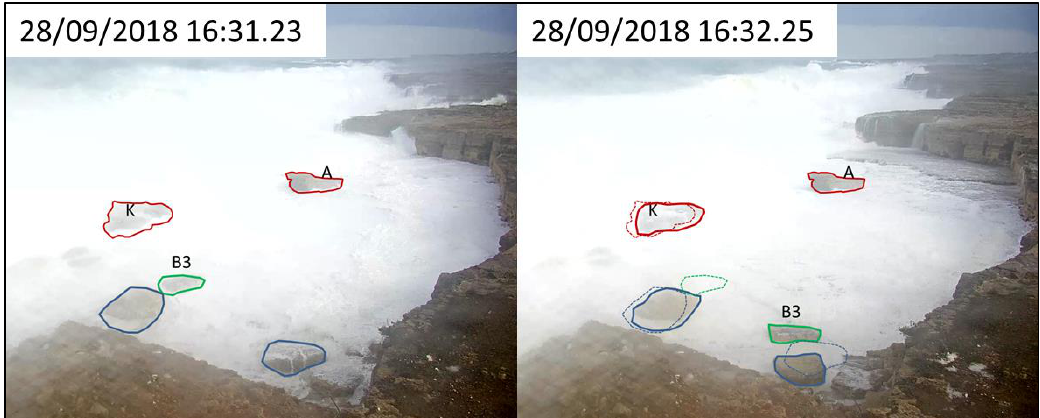
Figure 12. Morpho-topography of the shore-platform showing the boulders features assessed through photogrammetric (B2, B3, B4, BN) and Terrestrial Laser Scanner (TLS) (K) surveys.